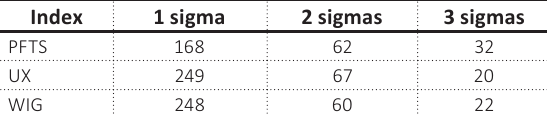
for ESG and conventional indices